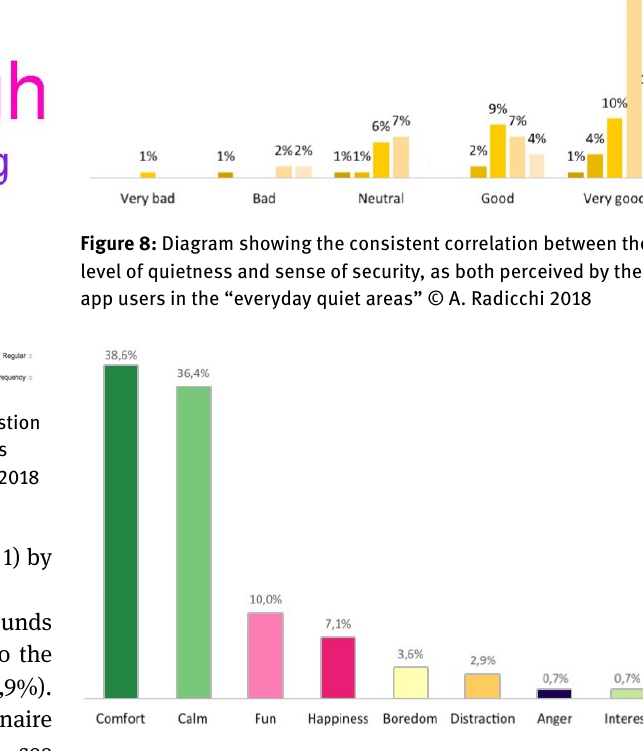
Figure 9: Diagram showing the emotions which prompted the app users to map the “everyday quiet areas” © A. Radicchi